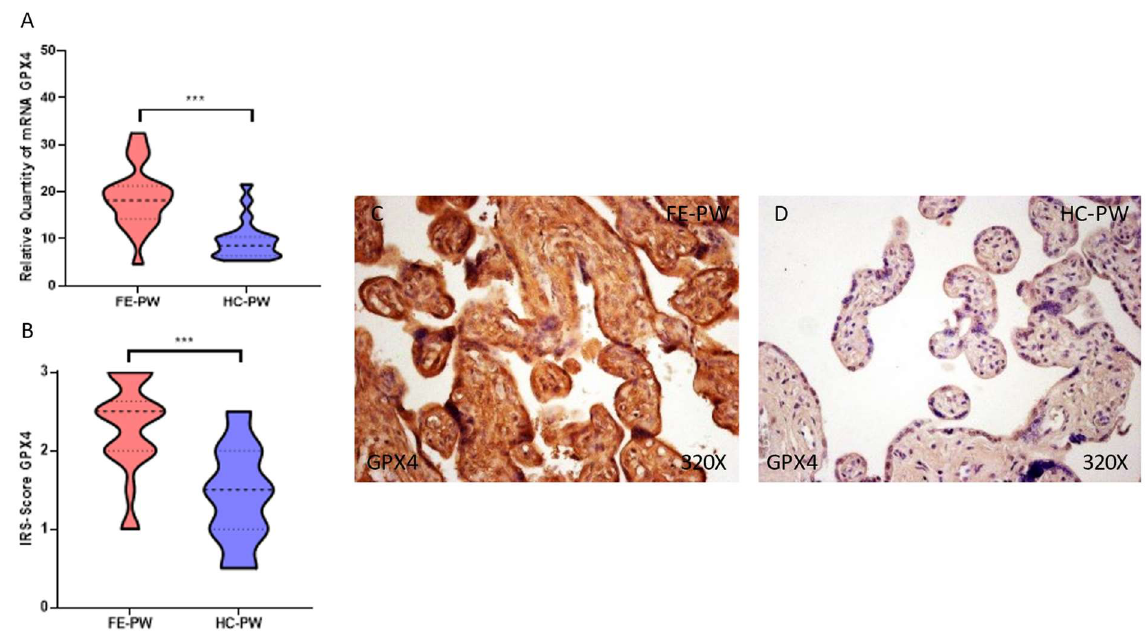
Figure 6. ( A ). GPX-4 mRNA expression in both the FE-PW (first episode of psychosis in pregnancy) and HC-PW groups (healthy controls). ( B ). IRS-Scores for GPX-4 expression in the placenta villi of the FE-PW group and the HC group. ( C , D ). Images showing the immunostaining for GPX-4 in